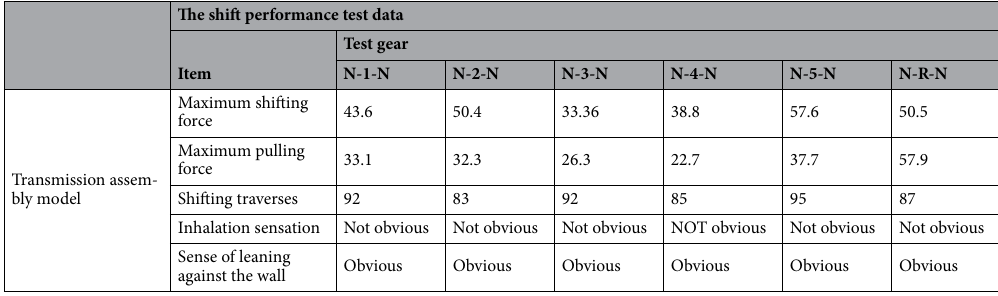
Table 1. Shifting performance comparison data of three gears.